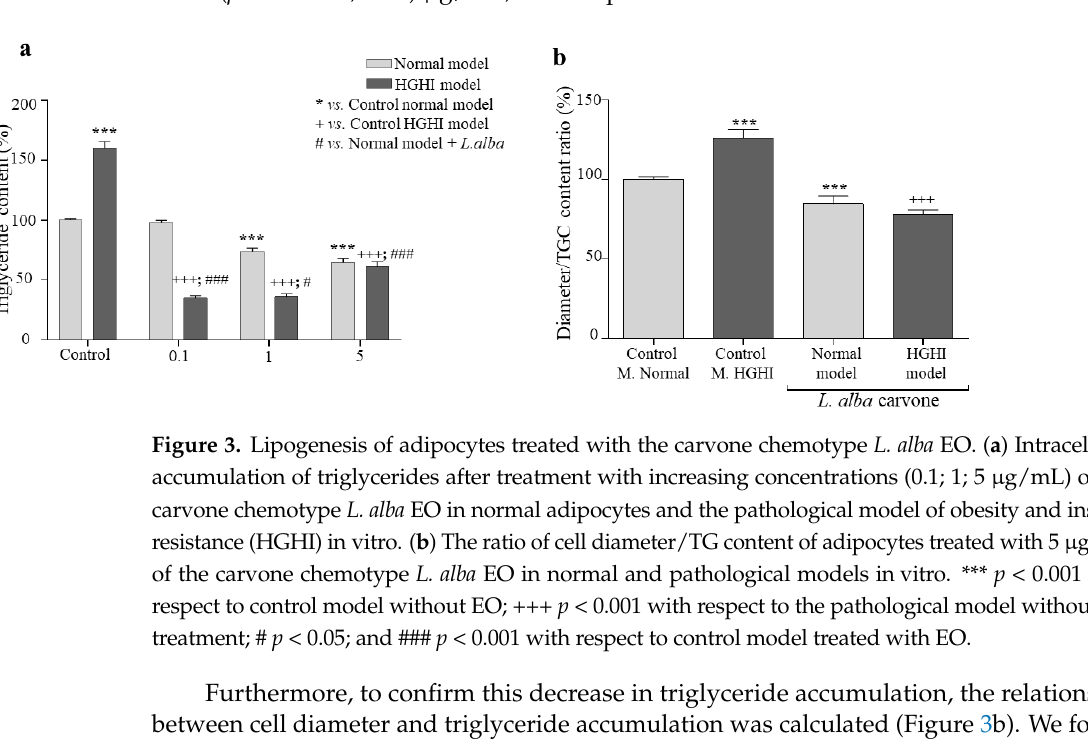
Figure 4. Lipolysis of the adipocyte. Free glycerol of the carvone chemotype L. alba EO. *** p < 0.001 vs. control (not treated with EO) of the HGHI model; *** p < 0.001 with respect to control model without EO; + p < 0.05; and ++ p < 0.01 with respect to the pathological model without EO treatment; ### p < 0.001 with respect to control model treated with EO. 3.6. Adipogenesis When evaluating the differentiation of adipocytes after treatment with the carvone chemotype L. alba EO, as shown in Figure 5a, for the adipocytes of the normal model, the expression of Pref-1 decreased in all the concentrations of EO used (0.1, 1, and 5 µg/mL)